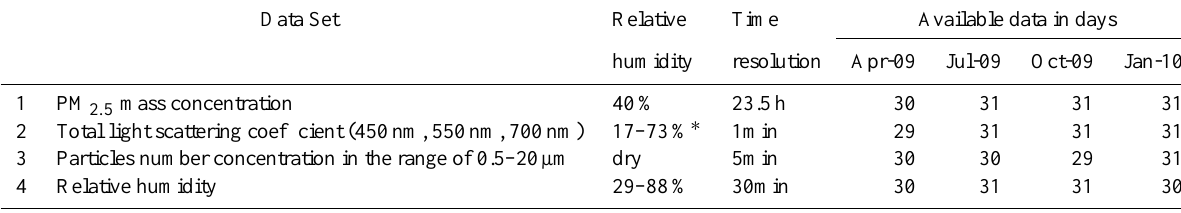
Table 1. Measured aerosol properties and meteorological